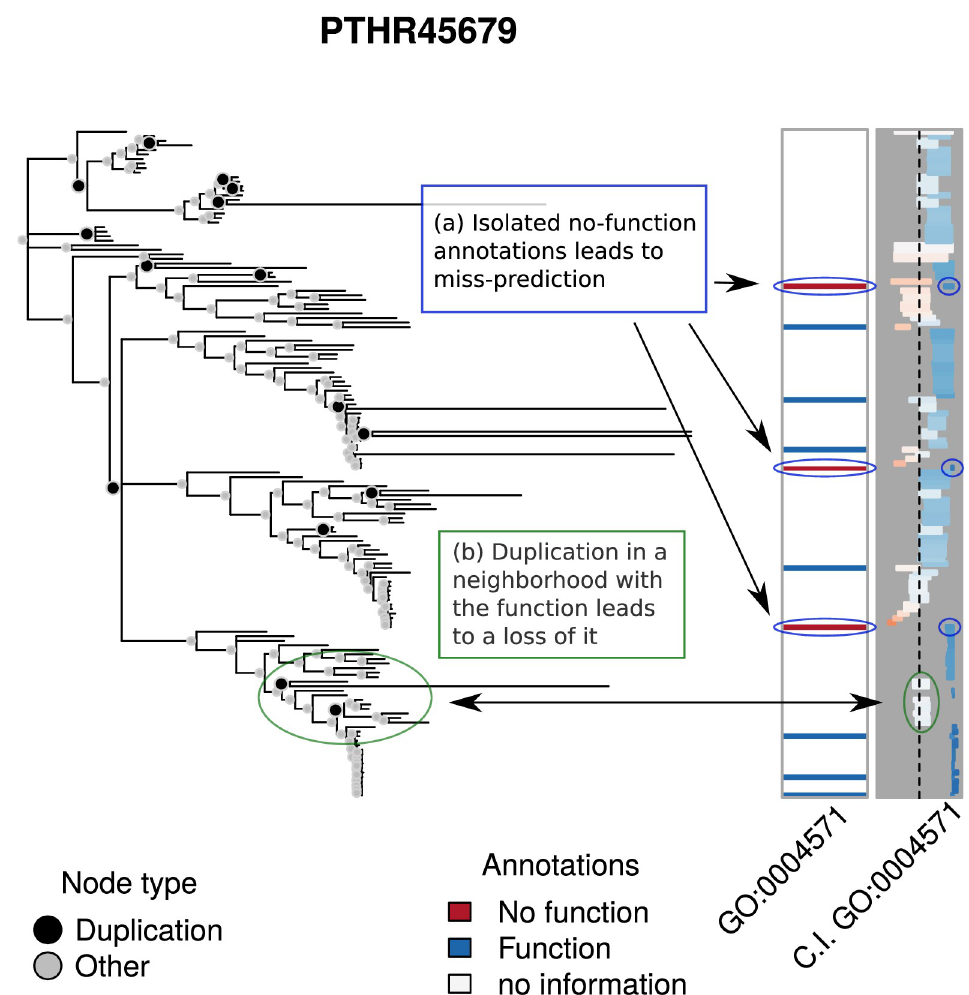
Fig 7. High MAE predictions. The first set of annotations, first column, shows the experimental annotations of the term GO:0004571 for PTHR45679. The second column shows the 95% C.I. of the predicted annotations using leave-one-out. Bars closer to the left are colored red to indicate that lack of function is suggested, while bars closer to the right are colored blue to indicate function is suggested. Depth of color corresponds to strength of inference. The AUC for this analysis is 0.33 and the Mean Absolute Error is